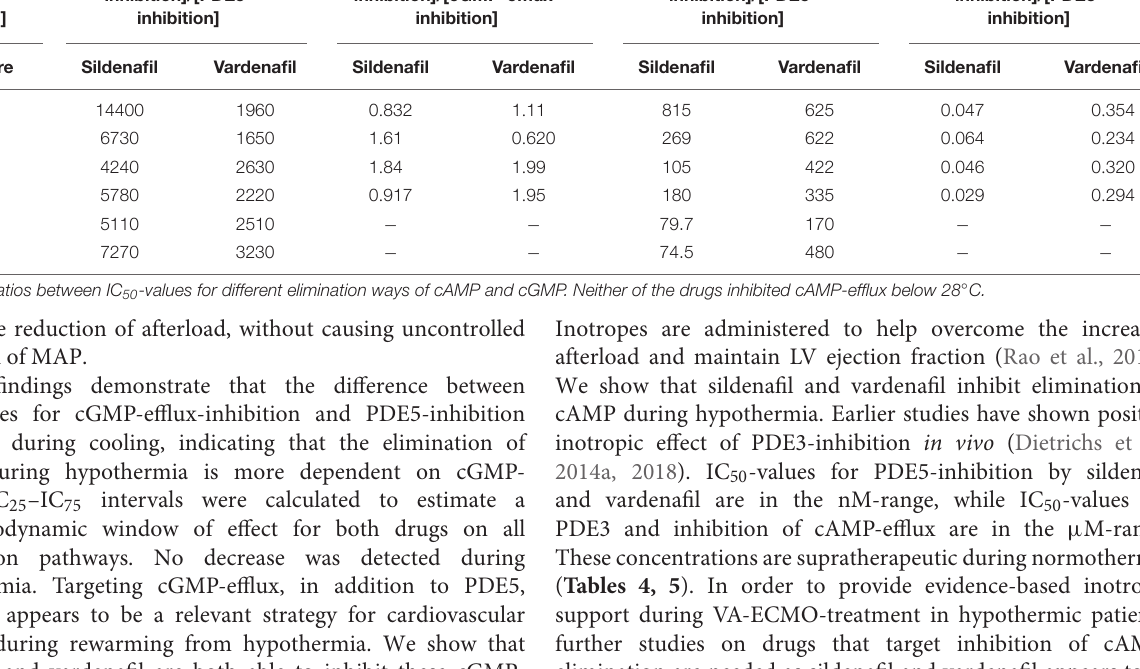
TABLE 7 | Drug selectivity for sildenafil and vardenafil at temperatures ranging from 37 ◦ C to 20 ◦ C. Drug